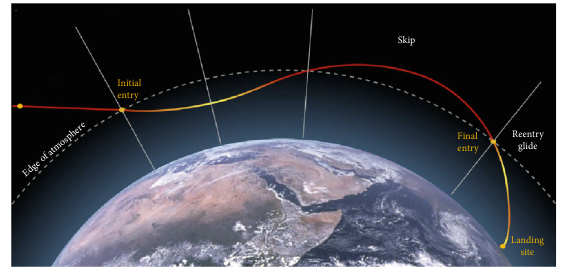
Figure 2: Sketch map of the “ boost+glide ” di ff erentiable nonlinear functions. Due to the uncertainty and the in fl uence of the unmodeled dynamics, the values of f ð x Þ and g ð x Þ cannot be accurately obtained. For a hyper-